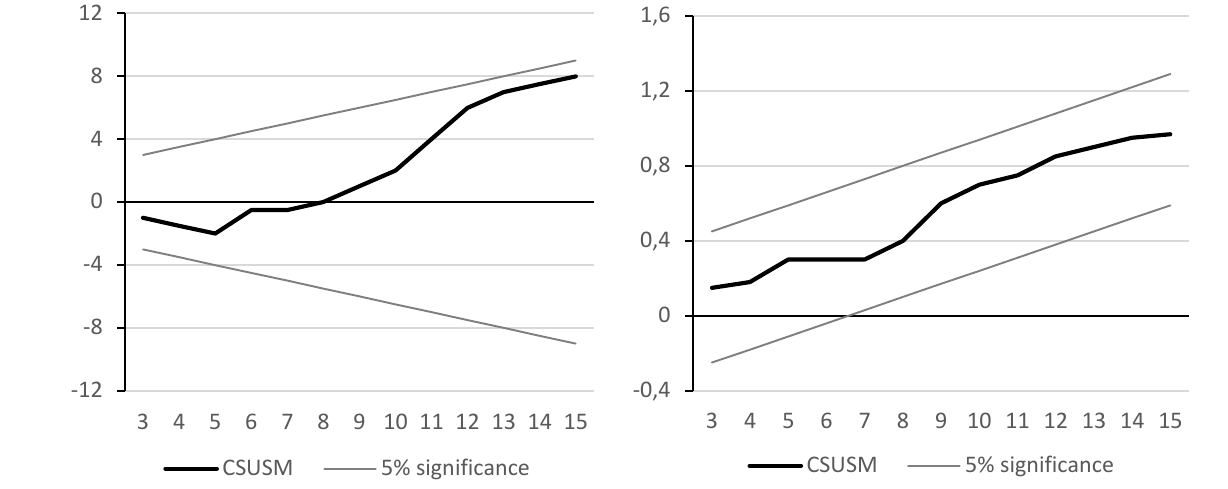
Figure 2. Cumulative sum of squares of recursive residuall (SUCUSM)